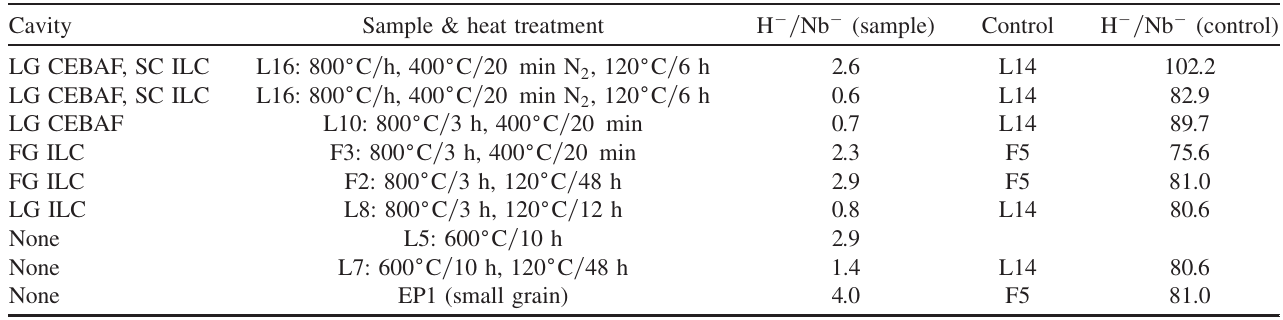
HIGH FIELD Q SLOPE AND THE BAKING EFFECT: . . TABLE V. SIMS H (cid:2) = Nb (cid:2) ratios for heat treated samples and corresponding control sample. All measurements at 14.5 keV Cs þ except for first L16 measurement made at 6 keV Cs þ . Cavity Sample & heat treatment